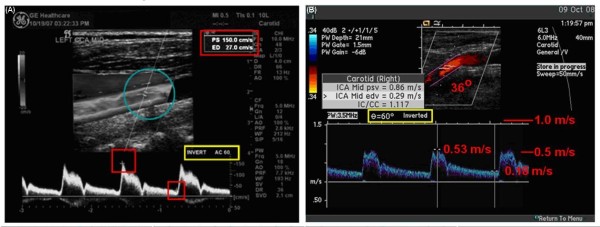
Normal CCA and ICA Images. A. This image was supplied to the UWURC on multiformat transparent film and scanned into the electronic image. Numbers in the red and yellow boxes have been enhanced for easier reading. B. The Doppler cursor is not aligned with the artery axis; the Doppler angle is 36°. A new velocity scale has been added in red along the right edge of the spectral waveform showing the results of the Doppler equation for a 36°angle.